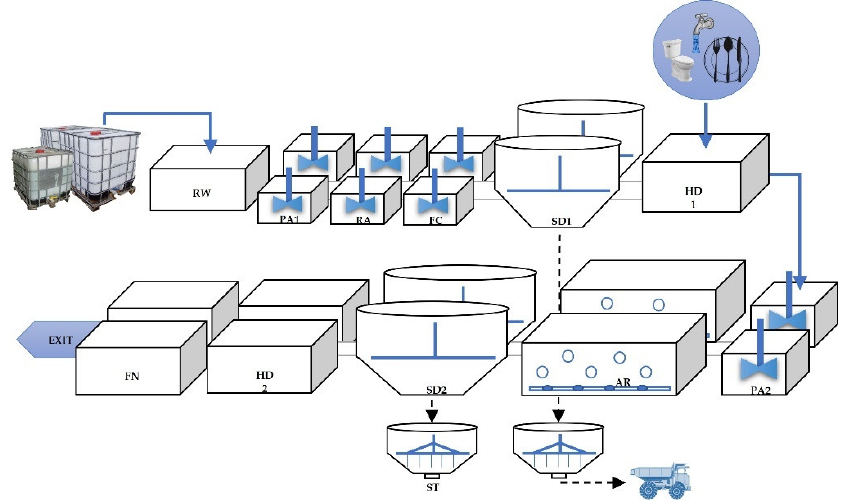
Figure 1. Schematic diagram of WWTs (abbreviation of unit type is denoted in Table 2). Measured concentrations of VOCs and characteristics of wastewater were used to- gether with design information of the WWTs as the input to determine the emission rate of VOCs from the WWTs using the WATER 9 emission model. USEPA allowed this com-